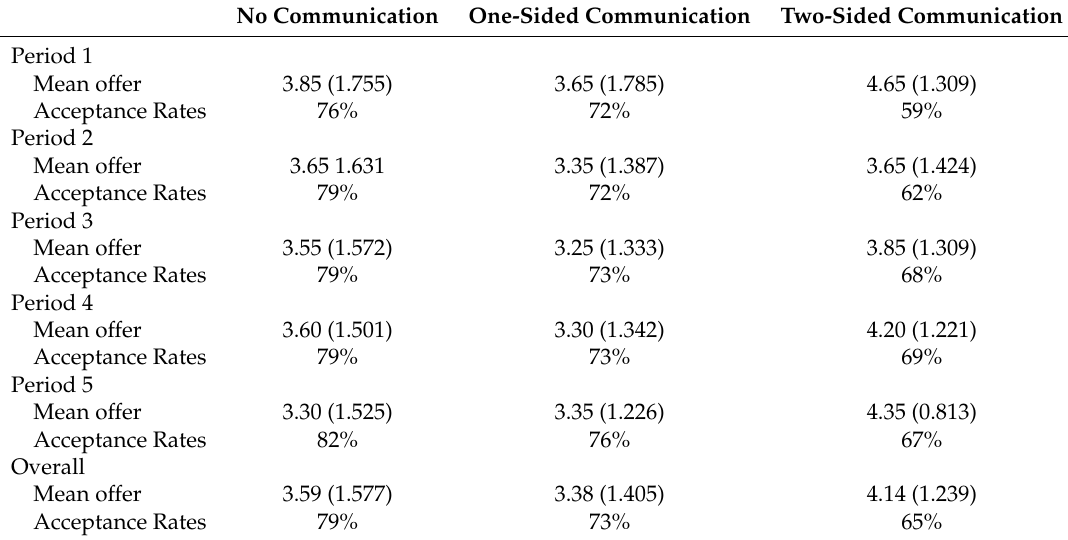
Table 2. Summary Statistics of Proposer and Responder